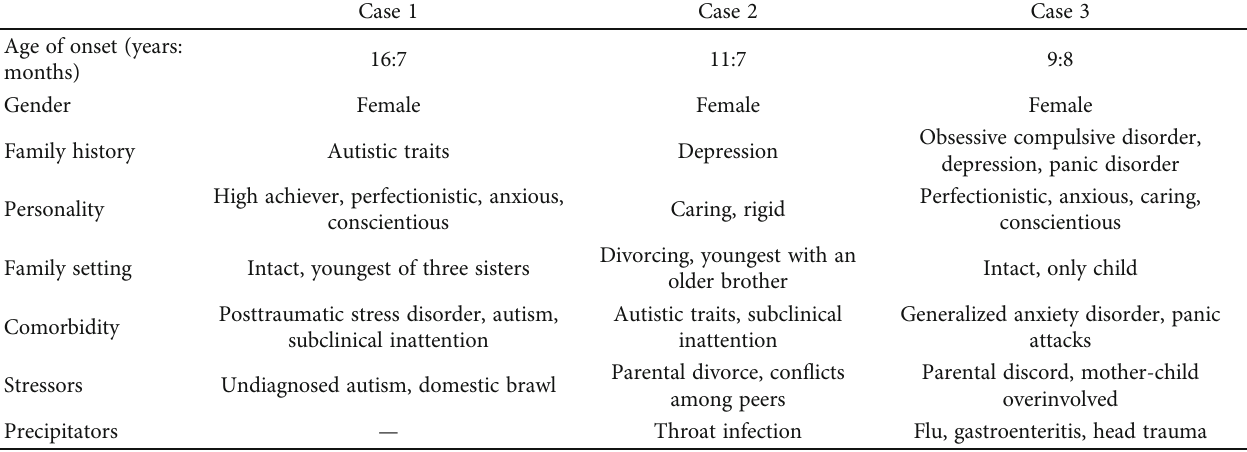
Table 2: Background characteristics.